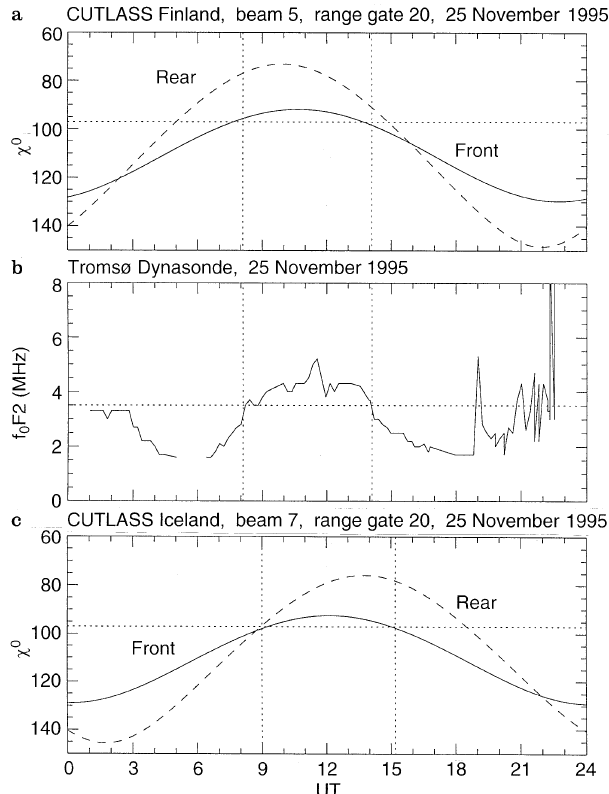
Fig. 8. a Diurnal variation of the solar zenith angle, (cid:115) , determined for beam 5, range gate 20, of the front ( solid line ) and rear ( dashed line ) fields-of-view of the Finland radar for 25 November 1995. b f (cid:48) F 2 determined from the Dynasonde located at Troms (cid:249) , Nor- way, for 25 November 1995. c Similar to a for beam 7, range gate 20, of the Iceland radar. See text for explanation of the horizontal and vertical dotted